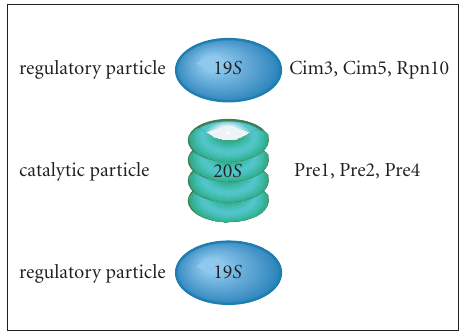
Figure 3. The structure of the 26 S proteasome. Two 19 S regulatory com- plexes straddle the openings to the 20 S particle, and control access to cat- alytic sites within the 20 S complex. Subunits in the base of the 19 S regula- tory particle are believed to perform a gating function that regulates the en- try of unfolded proteolytic substrates into the catalytic chamber of the core particle [50]. Heat-sensitive conditional mutants in the two distinct parti- cles of the proteasome have greatly assisted the functional characterization of the